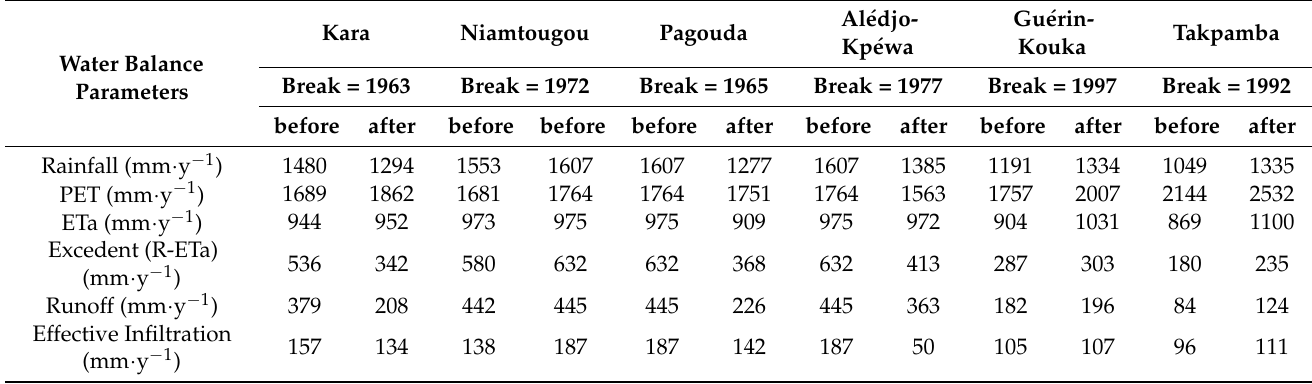
Table 4. Water balance parameters before and after the dates of break at the six KRW